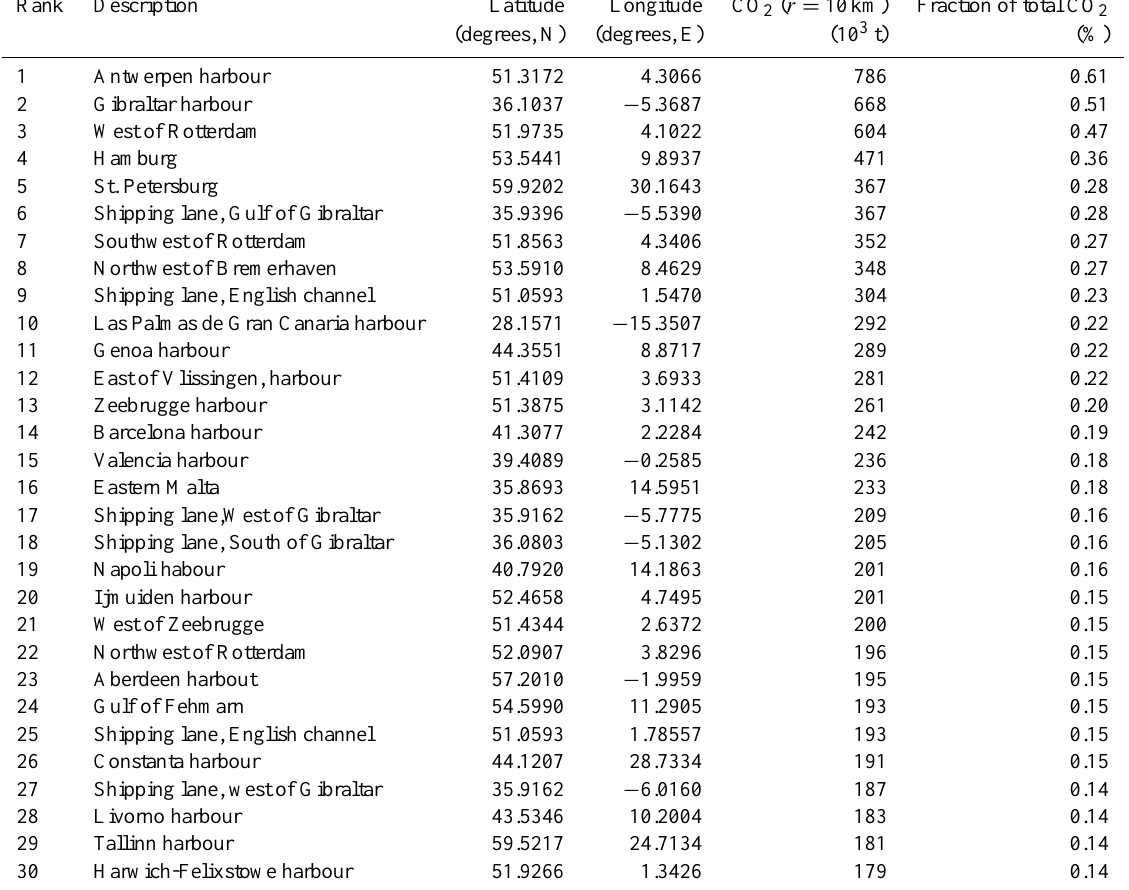
Table 2. The locations in European sea areas that contain the highest CO 2 emissions within a circular area that has a radius of 10km.